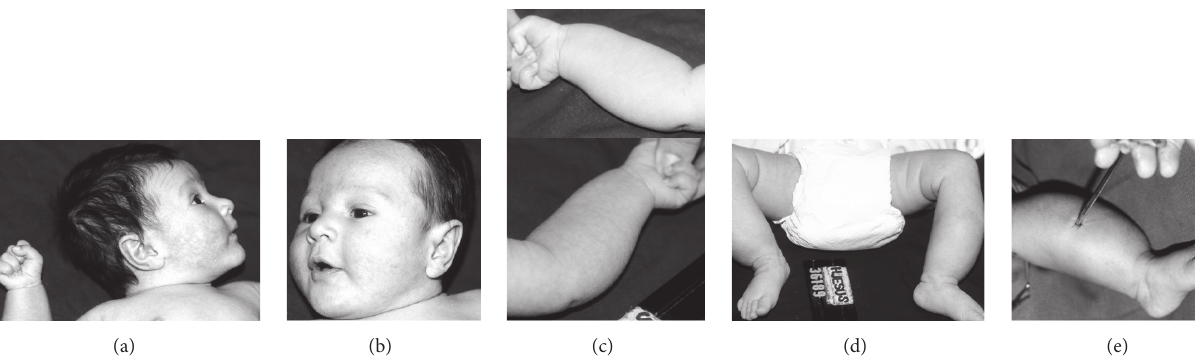
Figure 1: Clinical manifestations. ((a) and (b)) Facial swelling of ICH neonatal patient at 17 days of age. The swelling of the right and left cheeks is evident. (c) Photograph of the right and left forearms at 17 days of age shows that they are diffusely swollen. (d) Photograph of the lower limbs showing both legs visibly swollen. (e) Bone biopsy when patient was two months of age from the middle shaft of the